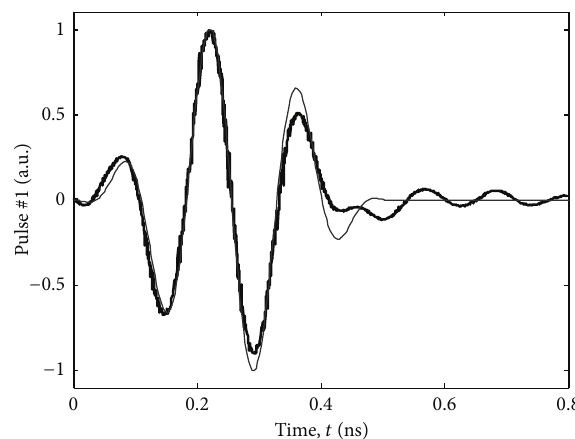
Figure 12: Performance of the pulse shaper for UWB radar and communications. Sinusoidal waveform windowed by a squared cosine:thetargetpulse(thinline),andthemeasurement(thickline).